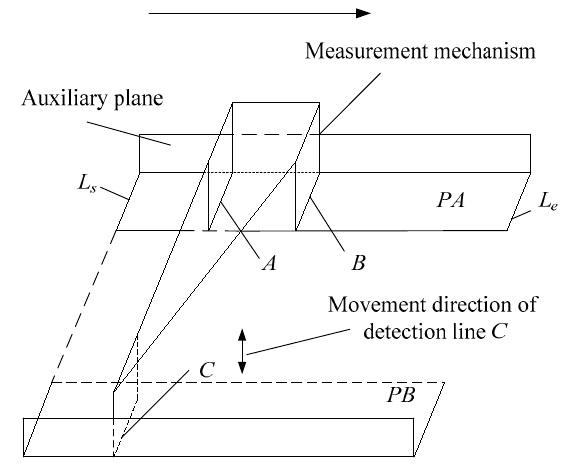
Figure 7. Detection model of two horizontal parallel surfaces.